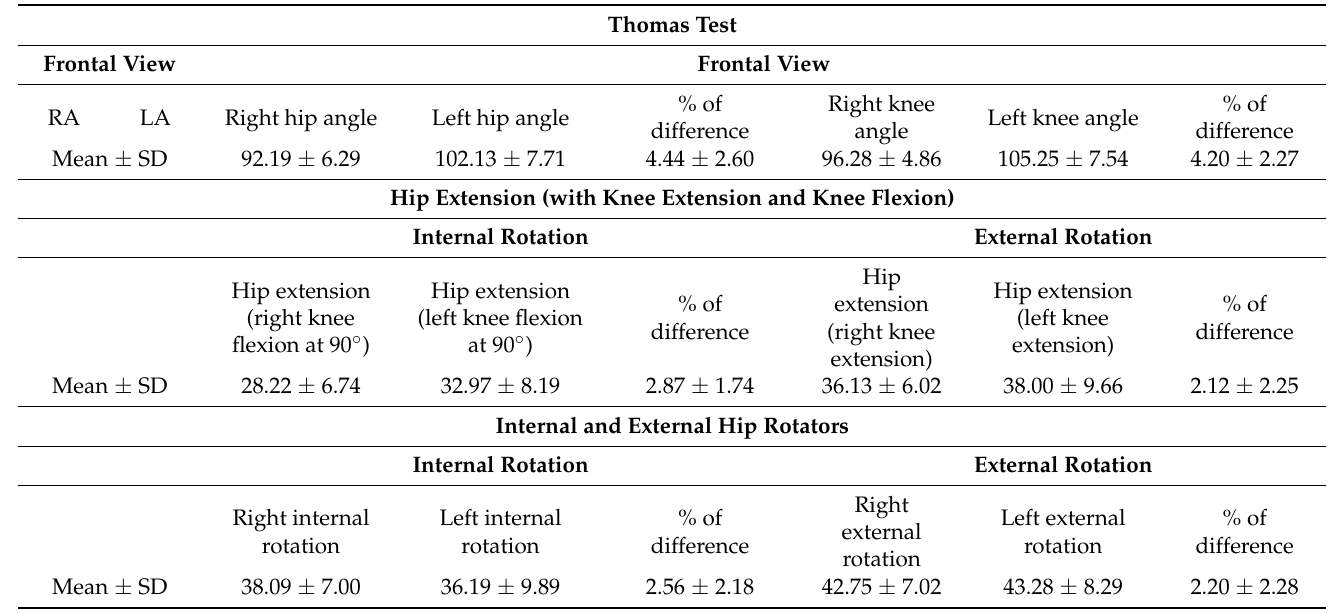
Table 2. Thomas test, hip extension (with knee extension and knee flexion), and internal and external hip rotators assessment. Thomas Test Frontal